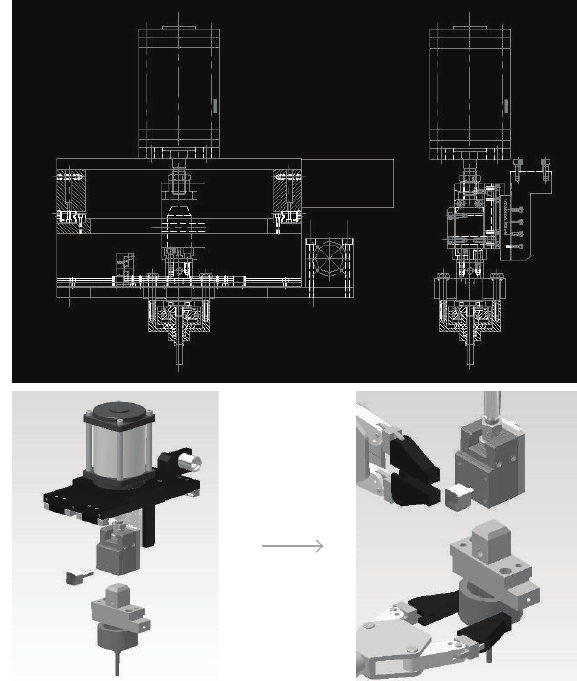
Figure 7: Illustration of designing, installing, and exchanging weld